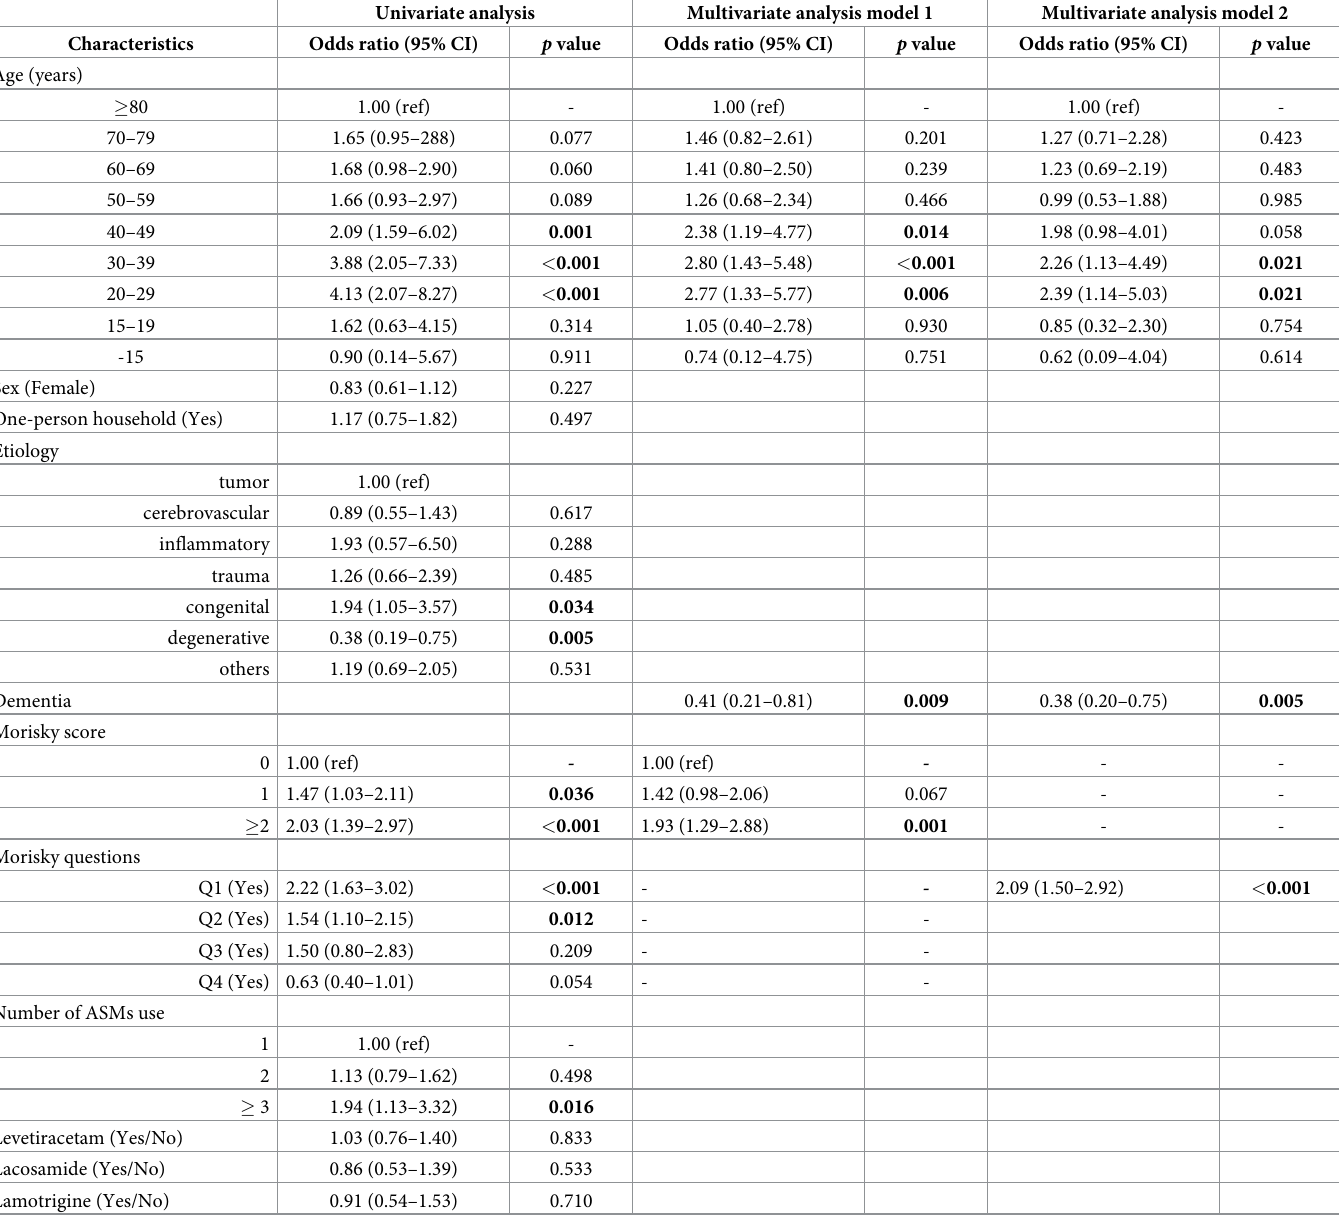
Table 3. The univariate and multivariate logistic regression analyses associated with focal to bilateral tonic–clonic